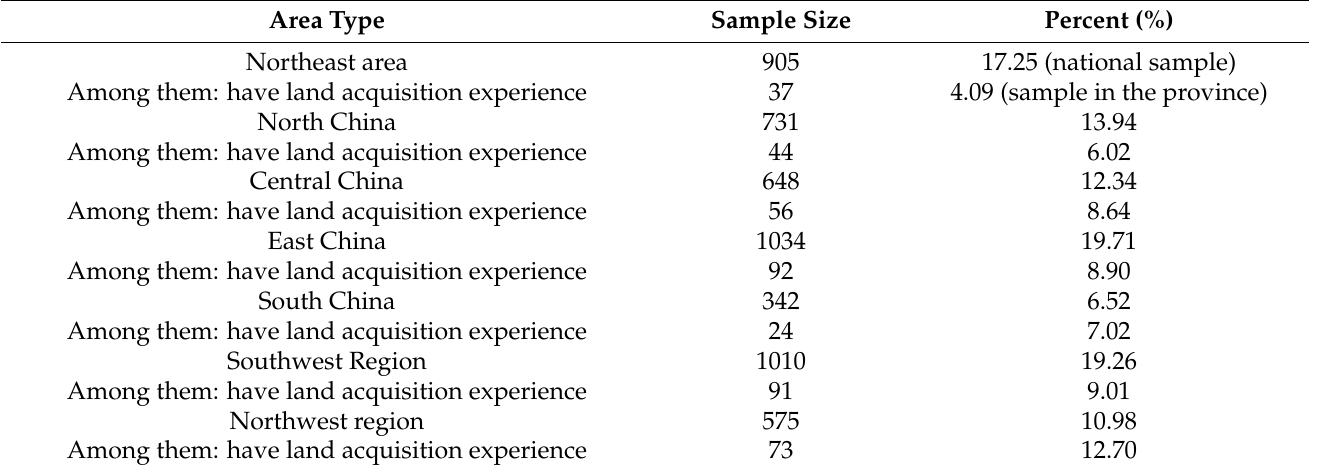
Table 1. Distribution of samples in seven regions of